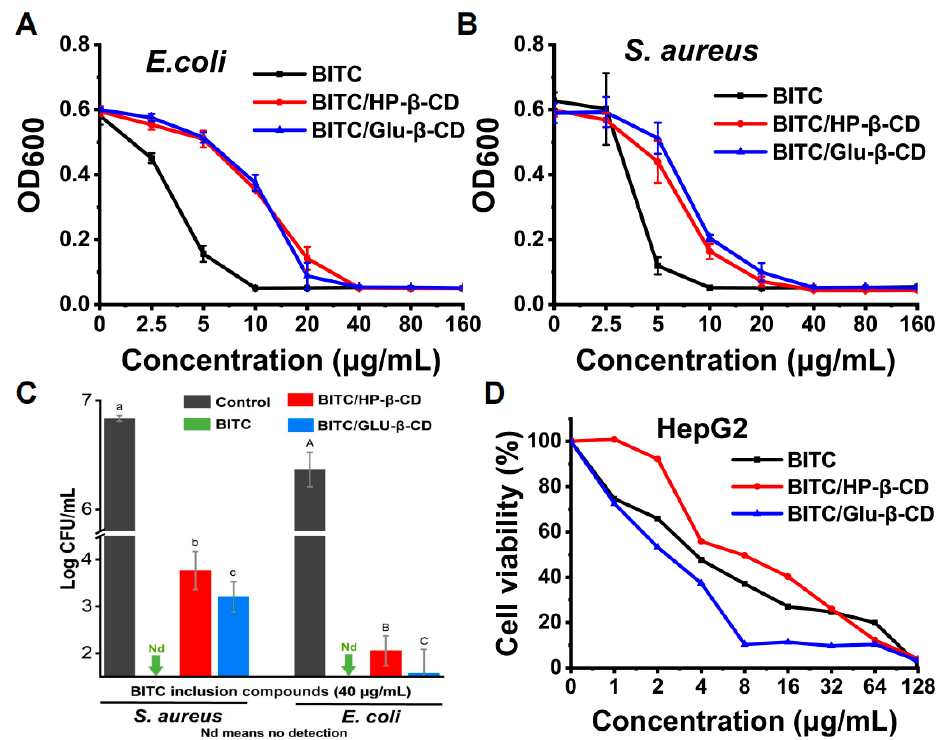
Figure 3. Anti-bacterial and anti-tumor activity of BITC- β -CDs. ( A ) and ( B ) Anti-bacterial activity of BITC, BITC/HP- β -CD, and BITC/GLU- β -CD on E. coli and S. aureus , respectively. ( C ) Bactericidal activity of BITC and BITC inclusion complexes against S. aureus and E. coli . Letters A−C and a−c rep- resent statistically significant values at p ≤ 0.05 . ( D ) Anti-tumor activity of BITC- β -CDs on